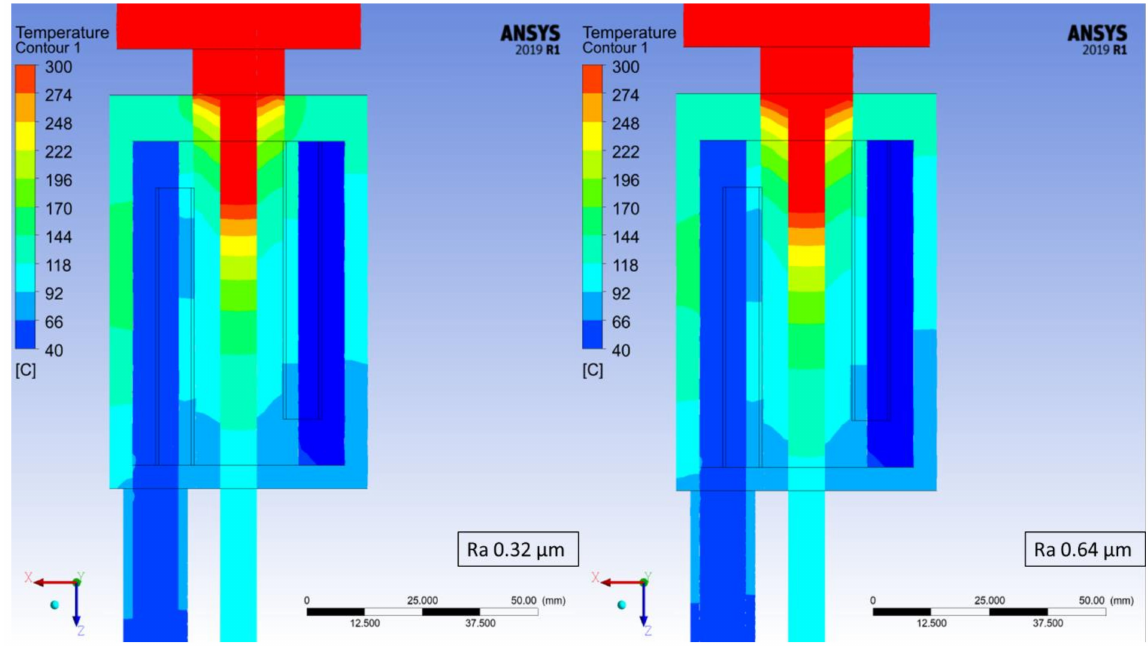
Figure 7. Continuous casting process simulation for the crystallizer with Ra 0.32 µ m ( left ) and Ra 0.64 µ m ( right ); step 900 of the simulations (450